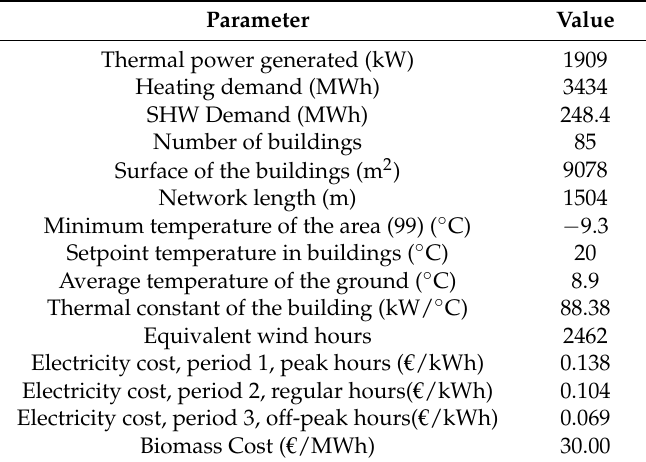
Table 1. Common characteristics of both DH